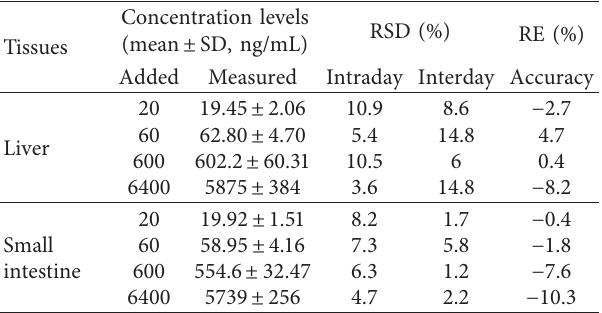
Table 3: Precision and accuracy data for the quantification of crizotinib in mouse tissue homogenates ( n �